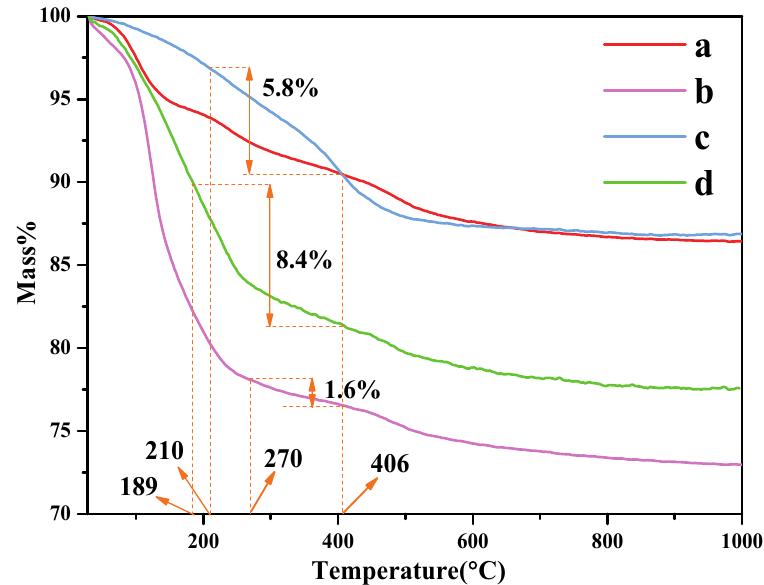
Figure 4. TG curves of ( a ) original kaolinite; ( b ) the KAc–kaolinite complex; ( c ) the FA–kaolinite complex; (d) the DMSO–kaolinite complex.